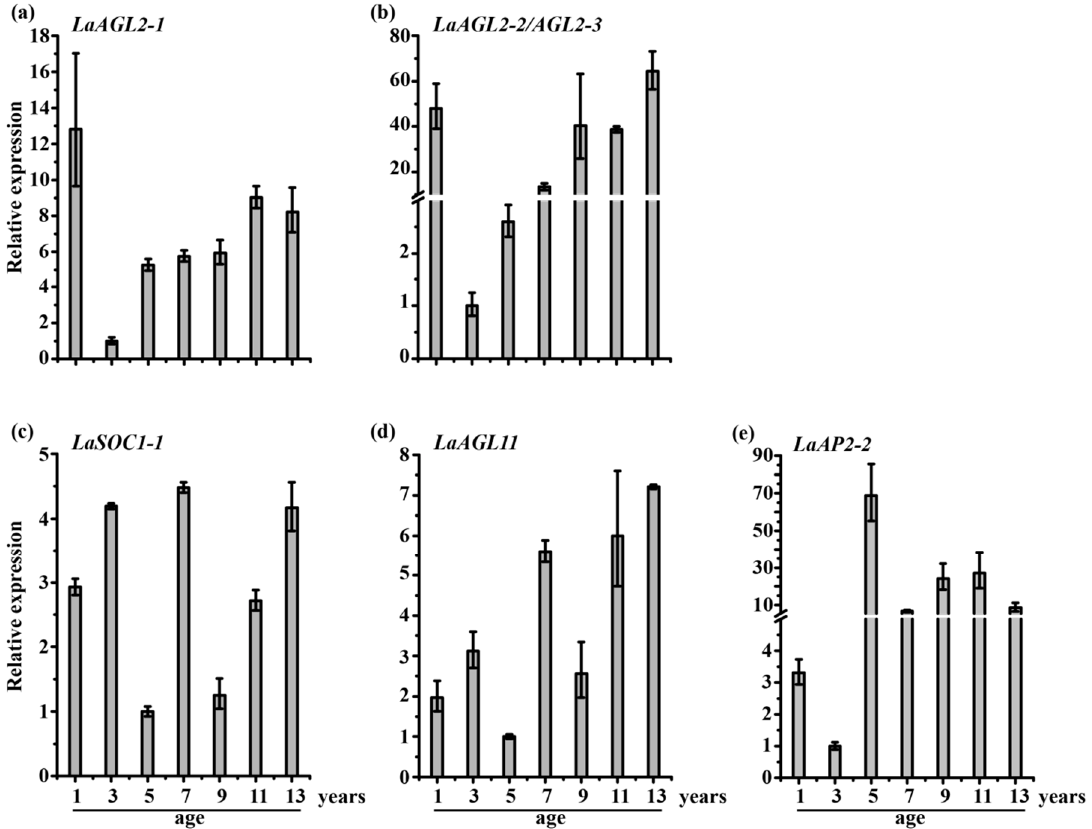
Figure 6. Expression patterns of LaAGL2 - 1 ( a ), LaAGL2 - 2 ( b ), LaAGL2 - 3 ( b ), LaSOC1 - 1 ( c ), LaAGL11 ( d ), and LaAP2 - 2 ( e ) in 1-, 3-, 5-, 7-, 9-, 11-, and 13-year-old Larix kaempferi cutting seedlings ( n ≥ 5, sampled in 2019) assayed by qRT-PCR with LaFBP1 as the internal control.